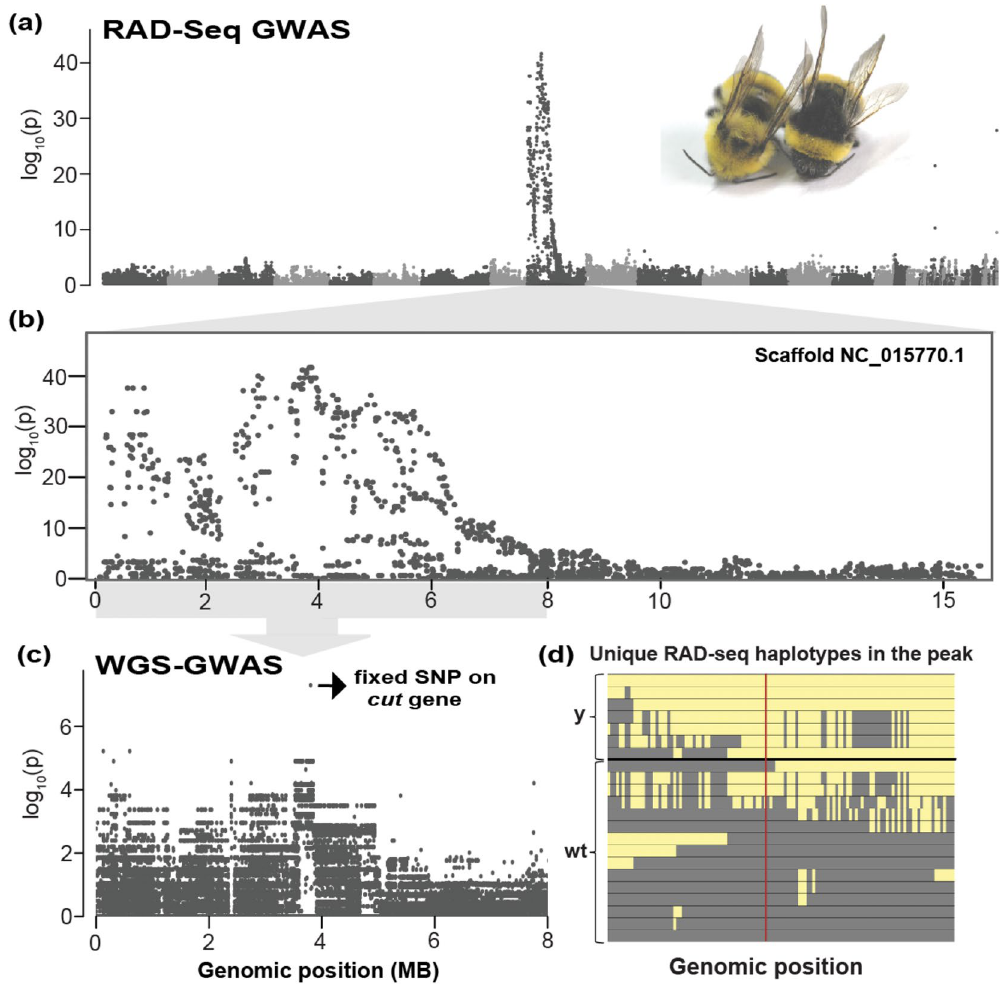
Figure 2. Identifying the color locus through a combination of WGS and RAD-Seq approach ( a ) A genome- wide Manhattan plot using RAD-Seq data reveals a single broad peak of association in scaffold NC_015770.1. Scaffolds represented in different grayscale shades. ( b ) Zoomed view of the Manhattan plot for scaffold NC_015770.1 ( c ) A Manhattan plot using whole-genome sequencing data of the peak region from RAD-Seq. A single fixed SNP on cut gene is highlighted. ( d ) A diagram of the unique haplotypes observed across RAD-Seq data in a ~ 3 MB (Genomic locations 2015753-5005430 on scaffold NC_015770.1) region of highest association used to select seven genetically distinct individuals for genomic sequencing of each color form. This is based on actual haplotypes of sampled individuals, focusing on a subset of SNPs that varied primarily between yellow mutant and wildtype individuals. SNPs are colored the color of the variant with the highest frequency of each allele (Yellow [y] for the mutant and gray for the wildtype [wt]). The red line indicates the position in the GWAS of the actual fixed SNP (not sequenced in RAD-Seq data). The filtered SNP dataset is deposited in Dryad digital repository [https:// doi. org/ 10. 5061/ dryad. wstqj